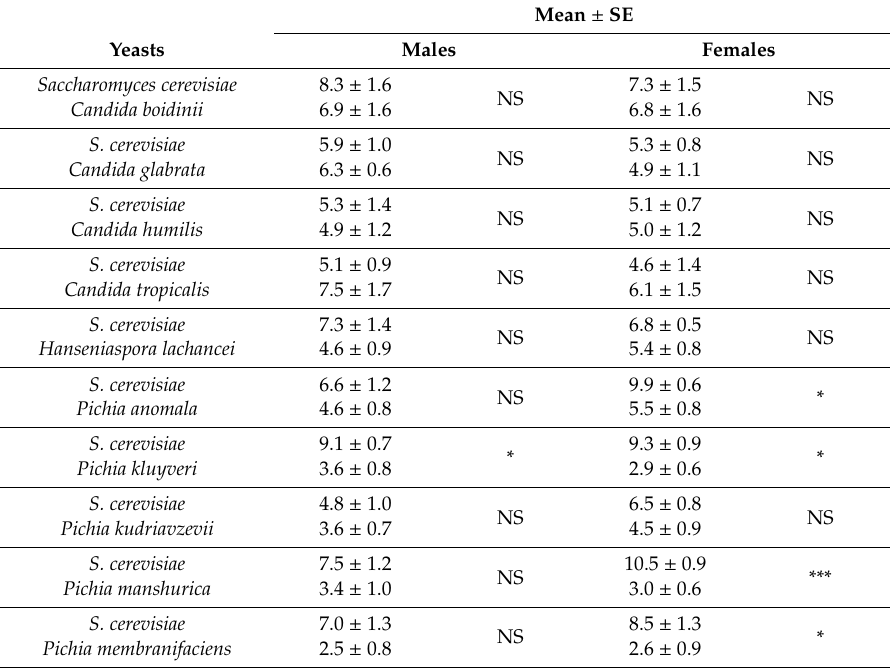
Table 4. Mean numbers of trapped males and females in laboratory pairwise comparisons of the reference yeast Saccharomyces cerevisiae (Tradi-Pan-Sc) with di ff erent species of Candida , Hanseniaspora , and Pichia grown in yeast-peptone-dextrose (YPD)